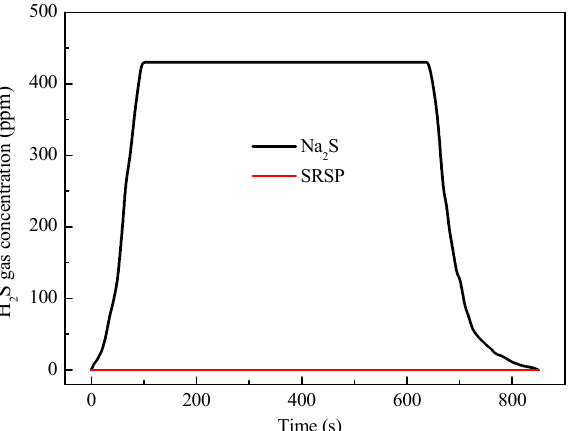
Figure 6. The H 2 S gas concentration at different times in the copper recovery process (experimental conditions: molar ratio of SRSP/Na 2 S to copper: 1:1, pH value: 0.70).